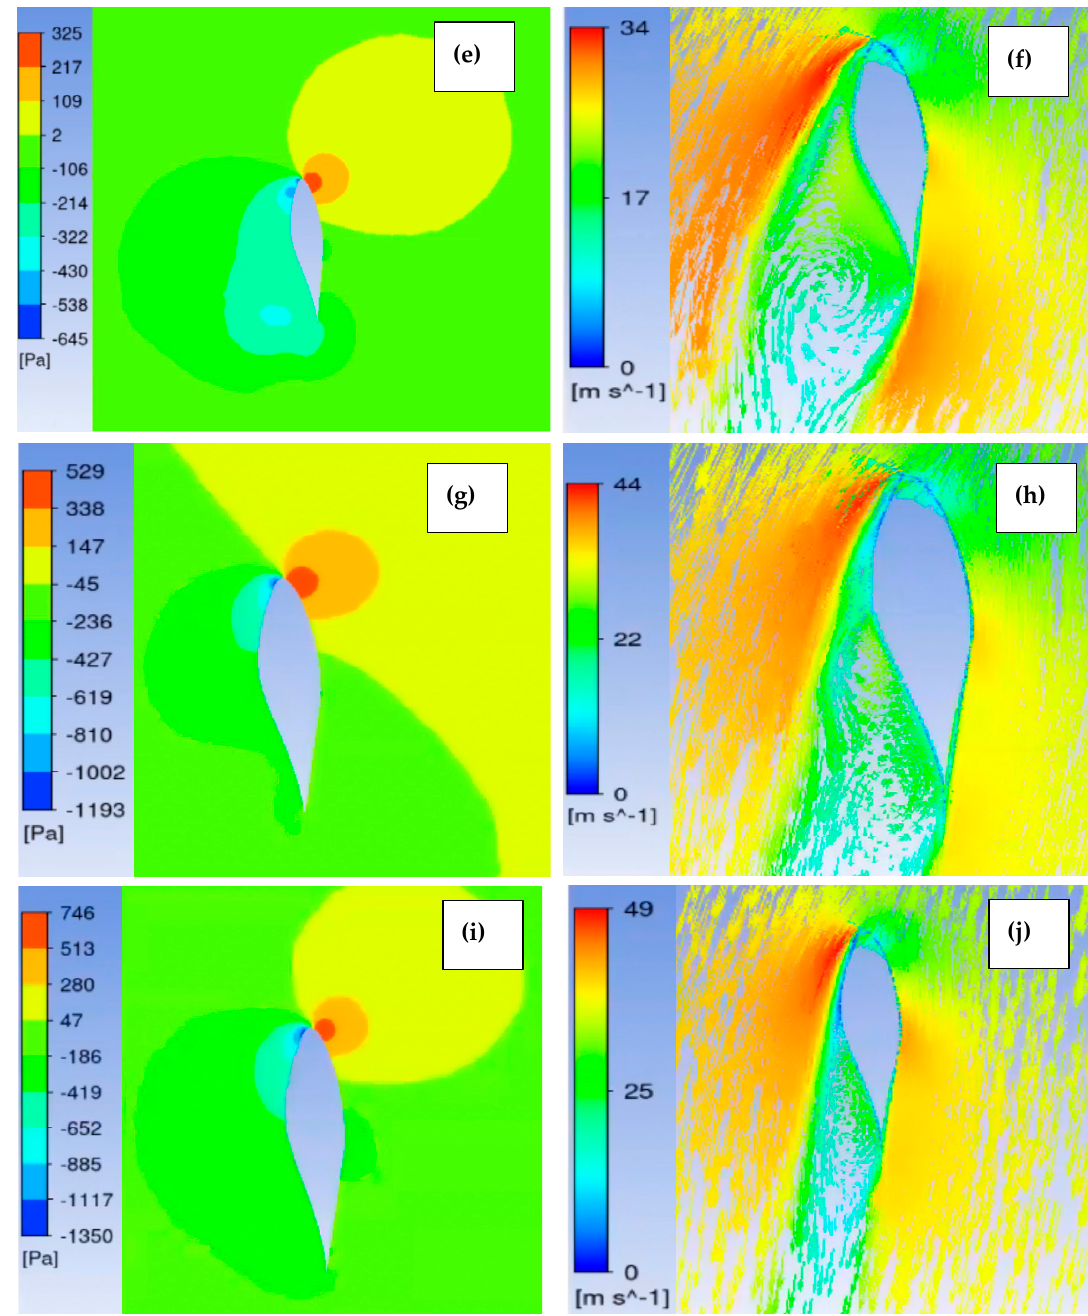
Figure 10. Pressure and velocity vector distributions at 7.2 m/s of different span stations: ( a ) pressure and ( b ) velocity vector of 30% span; ( c ) pressure and ( d ) velocity vector of 47% span; ( e ) pressure and ( f ) velocity vector of 63% span; ( g ) pressure and ( h ) velocity vector of 80% span; and ( i ) pressure and ( j ) velocity vector of 95% span.